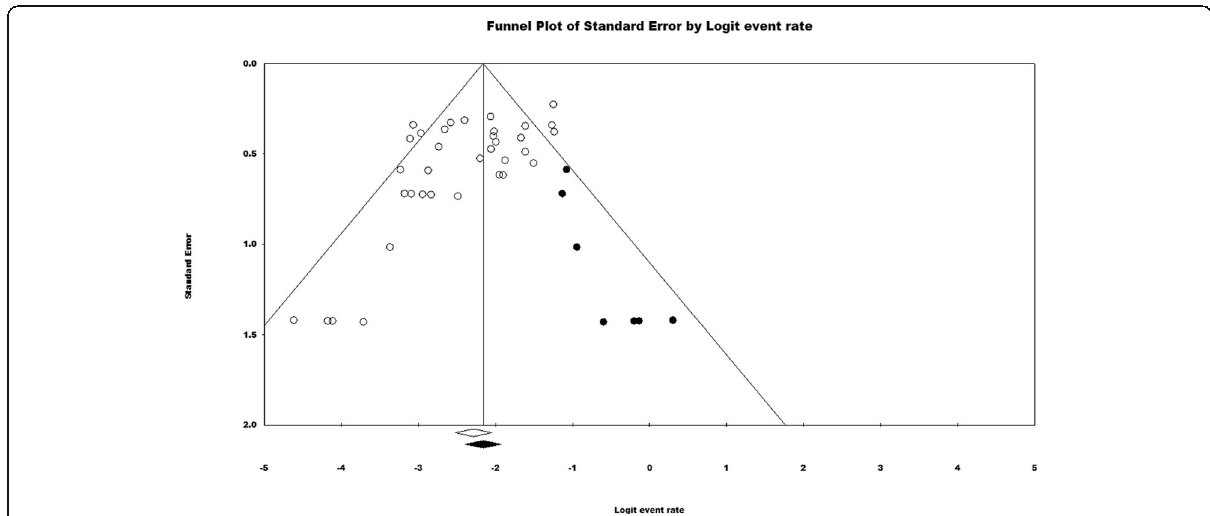
Fig. 11 Funnel plot of the studies reporting on the interradicular location between the maxillary first molar and second premolar (black dots denote the imputed missing